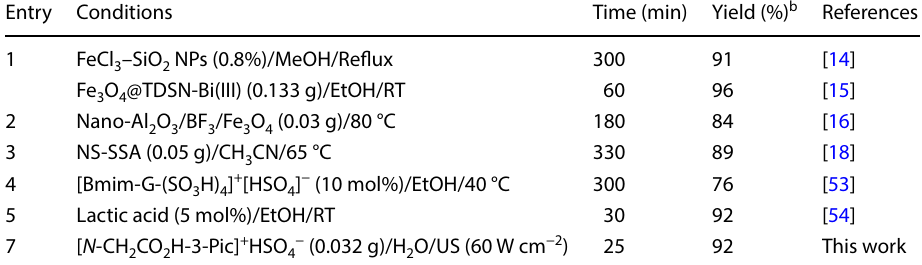
Table 3 Comparison of the methods in the synthesis of